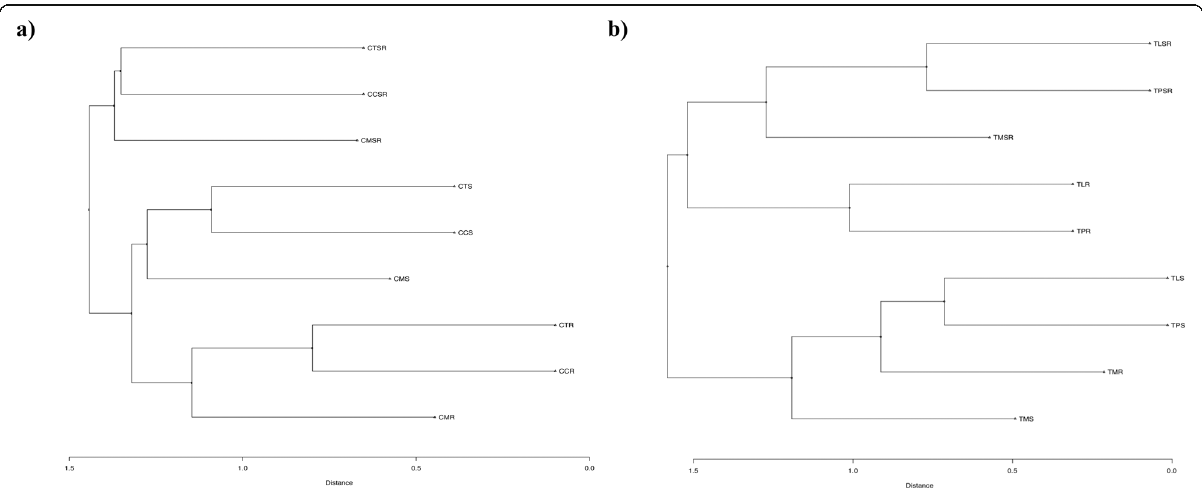
Fig. 2 Analysis of the Bray-Curtis beta-diversity index in the rhizosphere, rhizoplane, and root endophytic compartment of a C. annuum and b S.